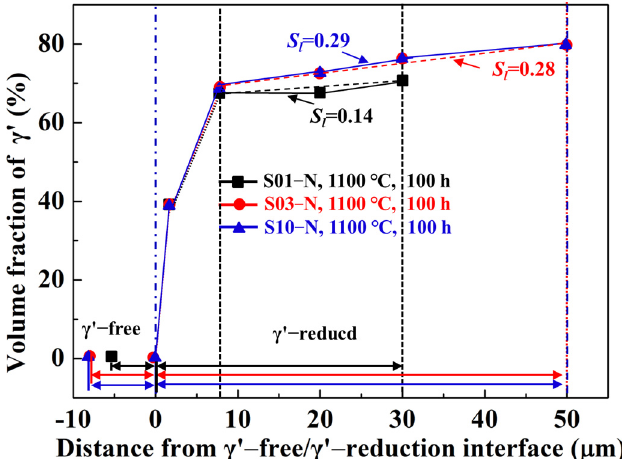
Figure 7. Volume fractions of γ ’ precipitates along the depth of the specimens of the IC21 alloy with different thicknesses after 100 h of cyclic oxidation at 1100 °C. The γ ’ − free layer was defined as the region with zero volume fraction of γ ’, while the γ ’ − reduced layer was defined as the region with a lower volume fraction of γ ’ than the original one (or that in the core). The fitted linear slopes of the gentle variation region in the γ ’ − reduced layer S l are shown as well.